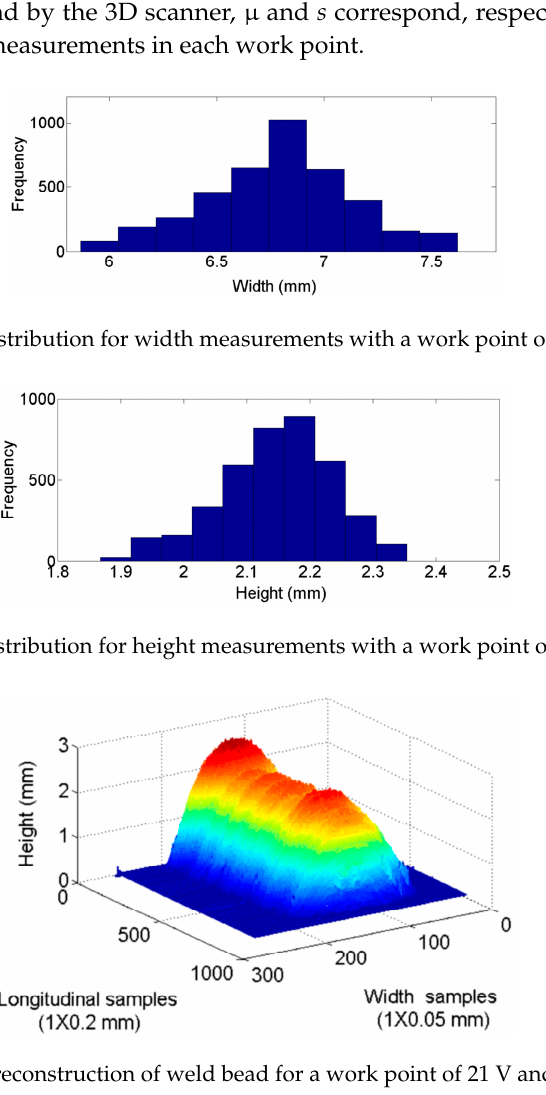
Figure 16. 3D reconstruction of weld bead for a work point of 21 V and 6 m/min.